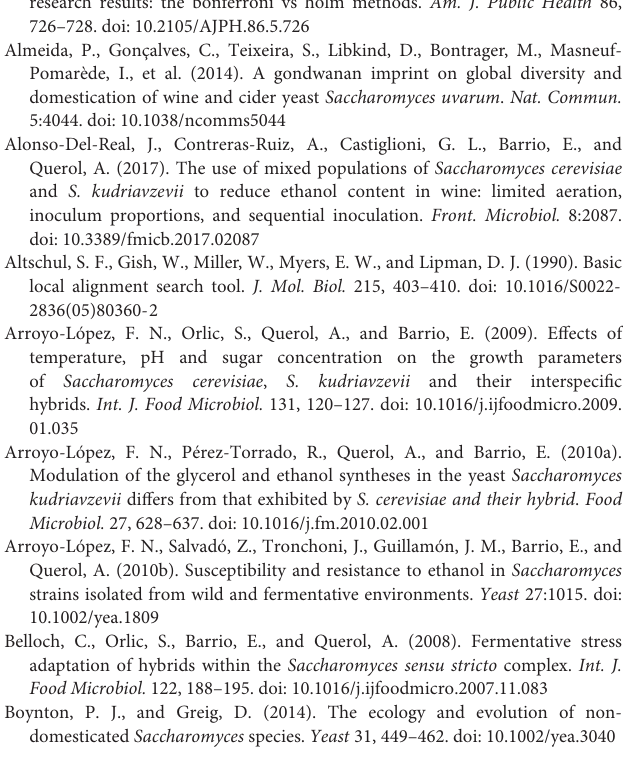
TABLE S3 | GO term enrichment for genes showing evidence of functional divergence in Sk and Sc branch. TABLE S4 | Amino acids sites under positive selection according to branch-site model and BEB method. Specific amino acids sites and the probability of being under positive selection were retrieved for those candidates obtained with the branch-site model. TABLE S5 | Enriched/Impoverished chromosome regions in proteins with functional divergence evidence. FIGURE S1 | Functional divergence among metabolic pathways. Normalized contribution of genes showing evidence of functional divergence to every path. The height of the bars represents (cid:56) , the normalized contribution of each pathway ( i ) of size ( t ) to the total number of genes under functional divergence when considering the whole dataset ( T ), calculated as (cid:56) = ( n i / t ) ( t / T ). Bars above the dashed line represent enriched pathways in genes under functional divergence while bars below the line show impoverished pathways. B, biosynthesis; M, metabolism; D, degradation; aa, amino acid. FIGURE S2 | Sk vs. Sc differences in functional divergence among metabolic pathways. Normalized functional divergence values among metabolic pathways. The significance of the differences in every pathway between analysis performed with Sk or Sc as clade-of-interest was assessed by a Wilcoxon paired signed-rank test, those significant were indicated with an “ ∗ .” B, biosynthesis; M, metabolism; D, degradation; aa, amino